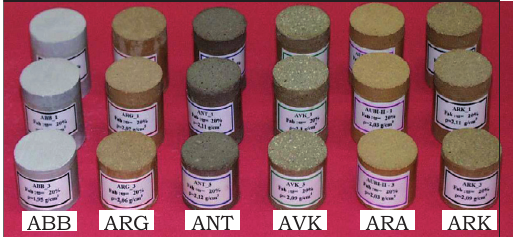
Fig. 2. Cylindrical test-tubes made of clay matrix. Six clay varieties: white clay of Bang´eli (ABB); red clay of Gu´erin- Kouka (ARG); black clay of Togbl´ekop´e (ANT); green clay of Kouv´e (AVK); red clay of Albi (ARA) and red clay of Kouv´e (ARK).